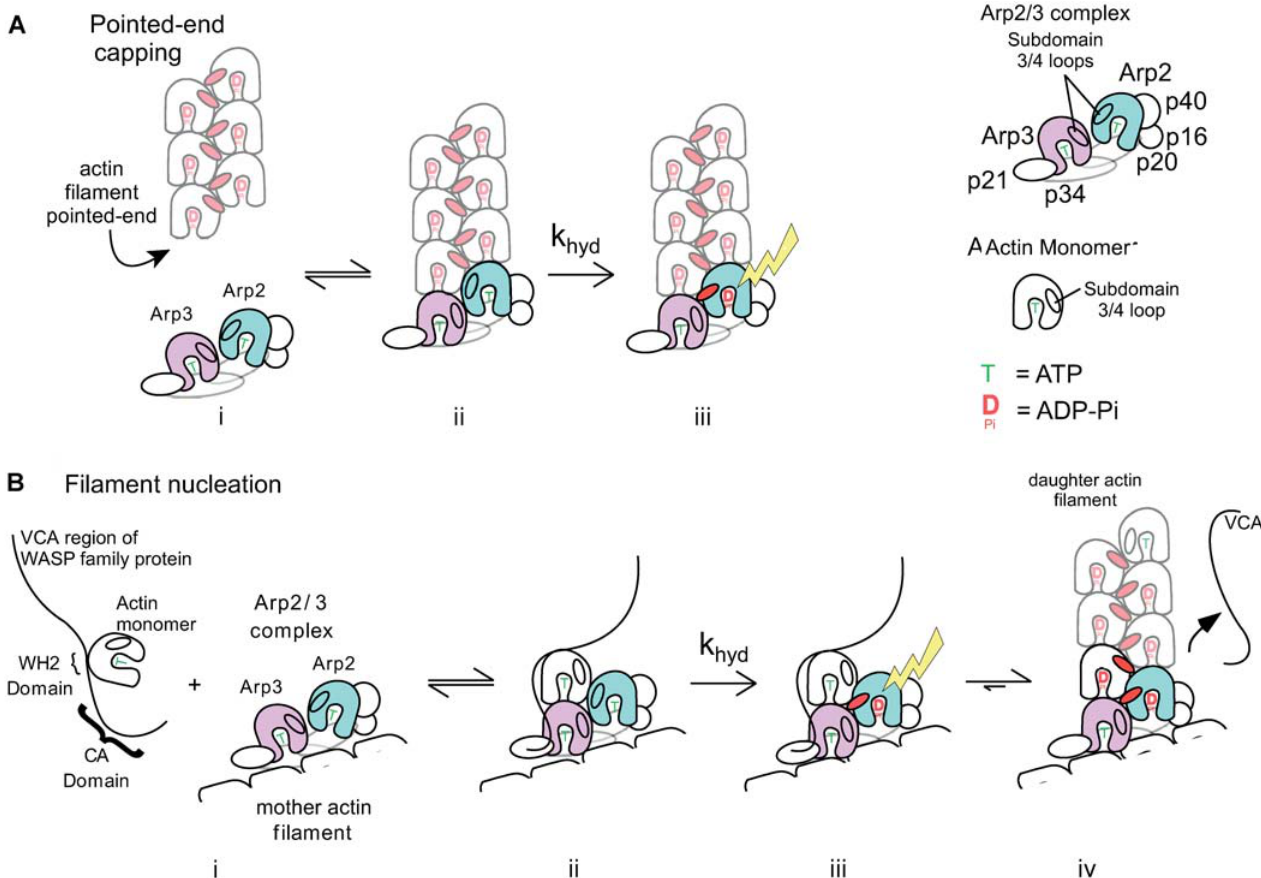
Figure 5. Model for Activation of ATP Hydrolysis on the Arp2/3 Complex and Mechanism by which WASP-Family Proteins Activate the Arp2/3 Complex to Nucleate New Actin Filaments (A) Filament pointed-end capping stimulates ATP hydrolysis on Arp2 without branch formation. (i) Arp2 and Arp3 are separated when the Arp2/3 complexisfreeinsolution.(ii)Uponpointed-endcapping,thebindingenergyoftheactin-Arp2/3interfacedrivesArp2andArp3togetherand(iii)a conformational change on Arp2 (shown by the red the subdomain 3/4 loop flipping out) triggers ATP hydrolysis by Arp2 (filament pointed-end capping is probably not a significant function of the Arp2/3 complex in vivo). (b) A VCA-bound actin monomer drives the activation of the Arp2/3 complex and stimulates ATP hydrolysis on Arp2. (i) The Arp2/3 complex must first be bound to the side of an actin filament, and an actin monomer is bound to the VC domain of the WASP-family protein. (ii) The VC domain of the WASP-family protein docks the first monomer of the daughter filament onto the Arp2/3 complex, stabilizing the Arp2–Arp3– actin interaction and promoting the active conformation of the complex. (cf. Aii). (iii) The active conformation of the Arp2–Arp3–actin monomer triggers a conformational change on Arp2 and ATP hydrolysis by the subunit. (iv) Actin polymerizes from the activated Arp2/3 complex. ATP hydrolysis by Arp2 may promote dissociation of the CA domain of the WASP-family protein from the Arp2/3 complex, aided